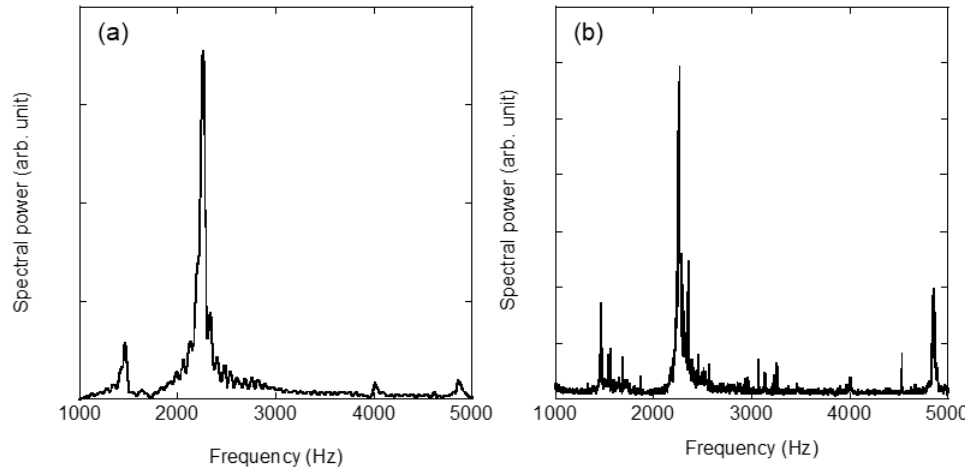
Figure 3. Vibrational spectra of the copper disk sample induced by ( a ) impulse hammer and ( b ) sweep pulse excitation.